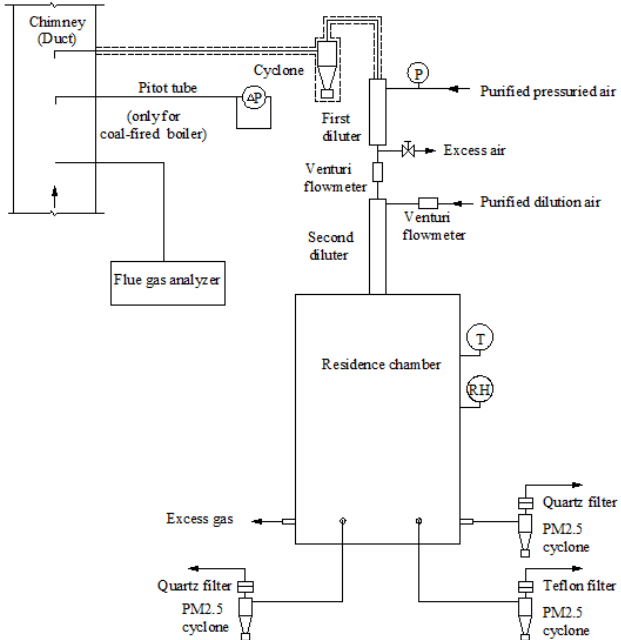
Figure 1. Schematic diagram of the dilution sampling system.